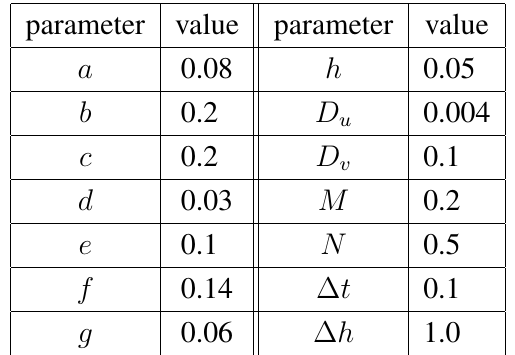
Table 1 . Parameter settings for reaction-diffusion equation.